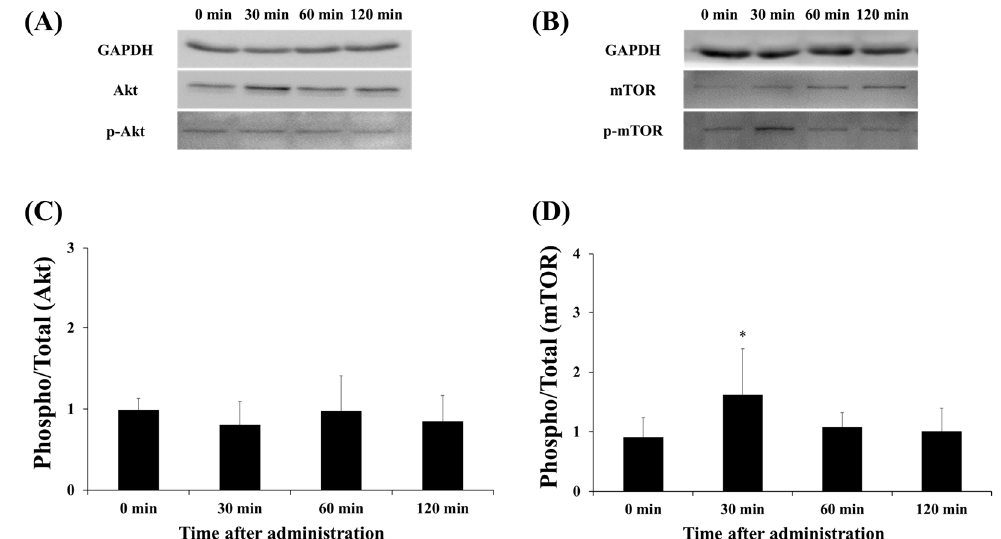
Figure 5. E ff ect of lactate administration on the protein expression of Akt and mTOR. ( A , B ) Western blot bands of Akt and mTOR. ( C ) The ratio of phosphorylated Akt to total Akt at each time point. ( D ) The ratio of phosphorylated mTOR to total mTOR at each time point. The experimental groups included the control group (0 min) and three groups studied 30, 60, or 120 min after lactate administration (2 g / kg). The values shown represent the means ± SDs ( n = 8). * p < 0.05, vs. the 0 min (control group).